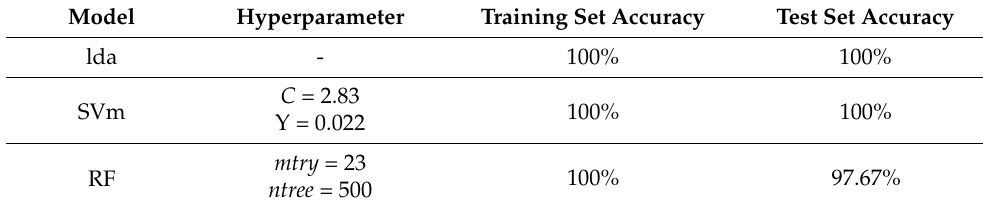
Table 2. Summary of the accuracy obtained by the classification models